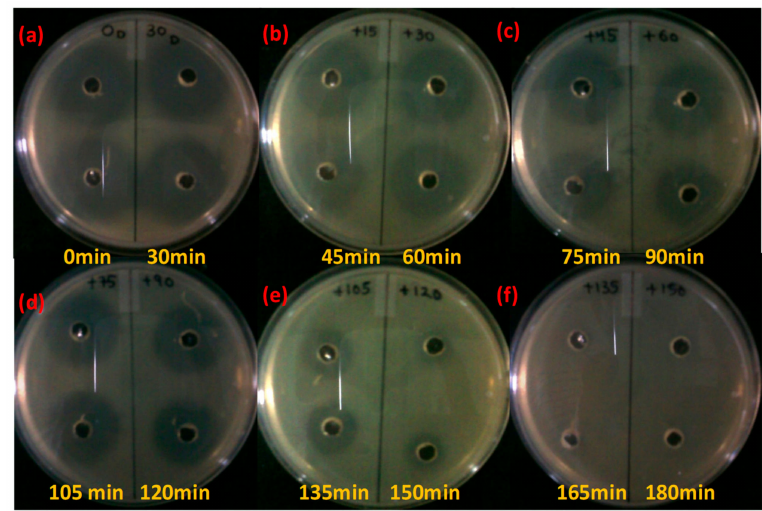
Figure 7. Residual antibiotic activity of the antibiotic ciprofloxacin after photocatalytic degradation with Fe Doped ZnO nanoparticles against Escherichia coli . Yellow marking denotes the time points at which sampling has been done. ( a ), ( b ), ( c ), ( d ), ( e ), ( f ) denotes the zone of inhibition shown by the antibiotic slurry collected at different time